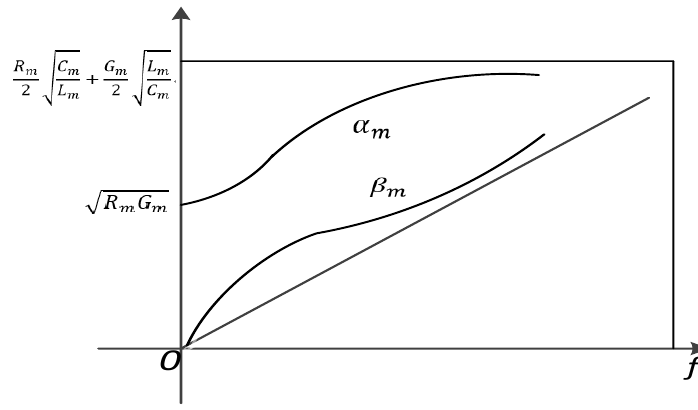
Figure 2. Relationship curve of α m ( ω ) , β m ( ω ) with respect to frequency.